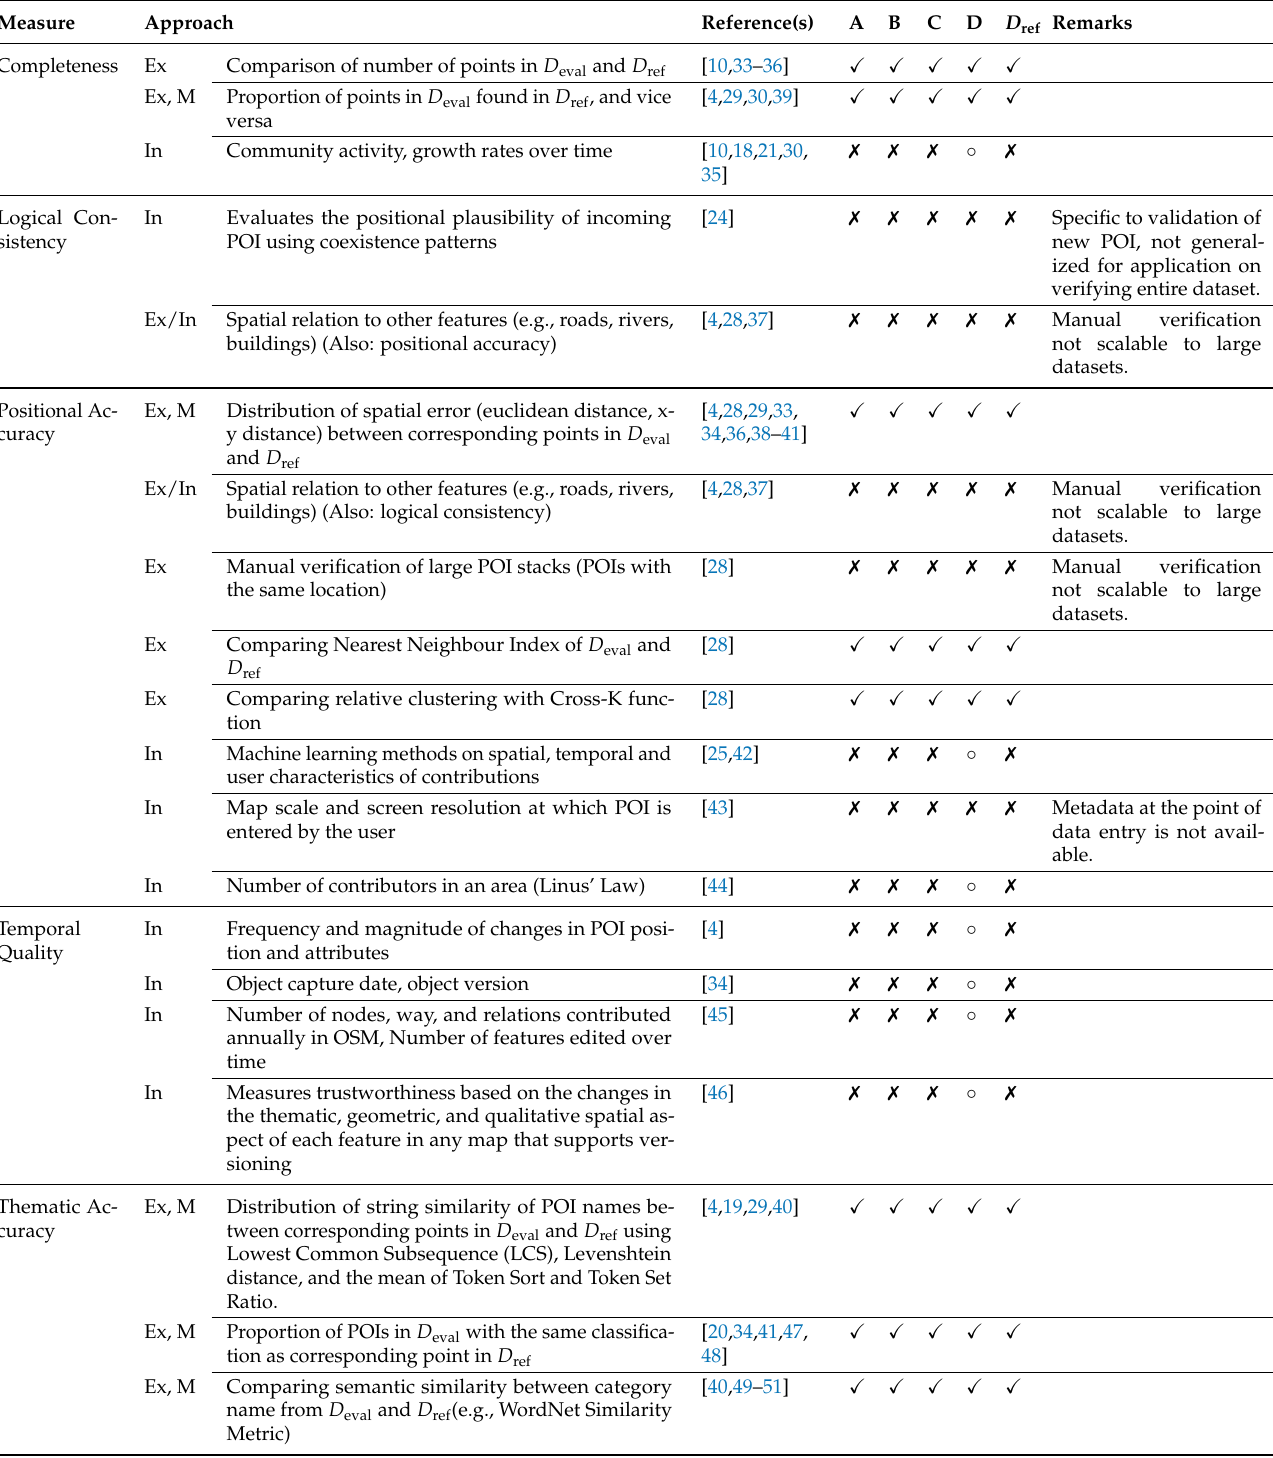
Table 1. Reviewed approaches for evaluating POI data quality. D eval refers to POI dataset being evaluated (A to D), while D ref refers to reference POI dataset. Checks and crosses indicate if approach was chosen for implementation in case study. Elaboration on why an approach was not chosen is provided in remarks